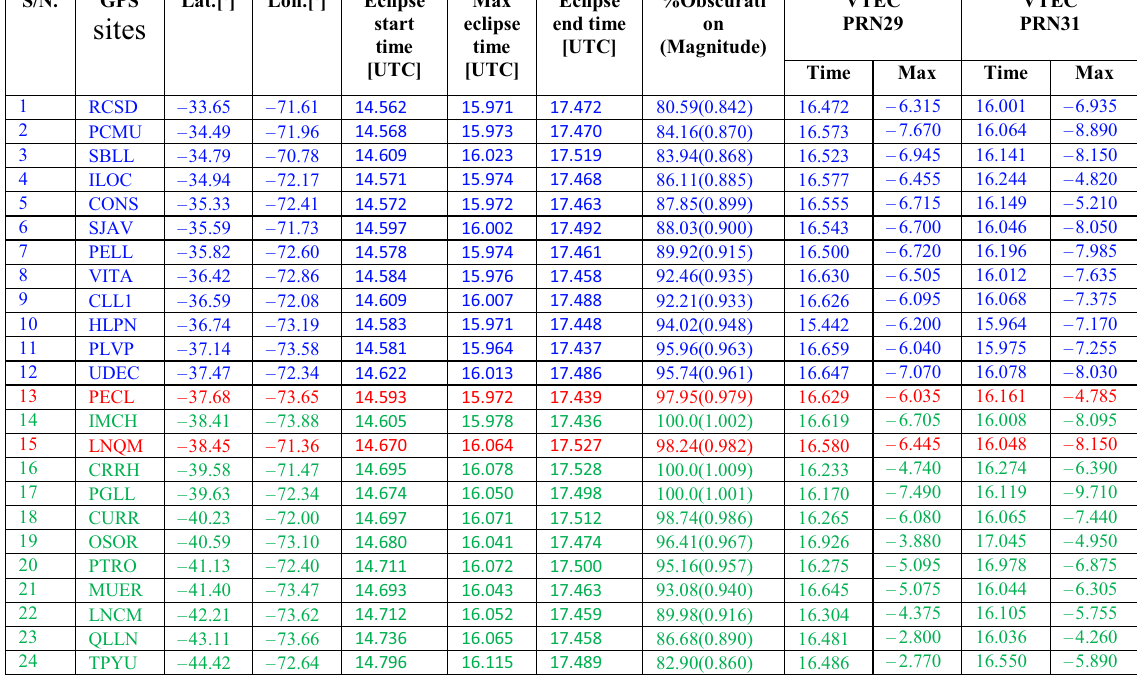
Table 1. Detail about the GPS sites analyzed, their location, eclipse condition, magnitude and change in VTEC at each